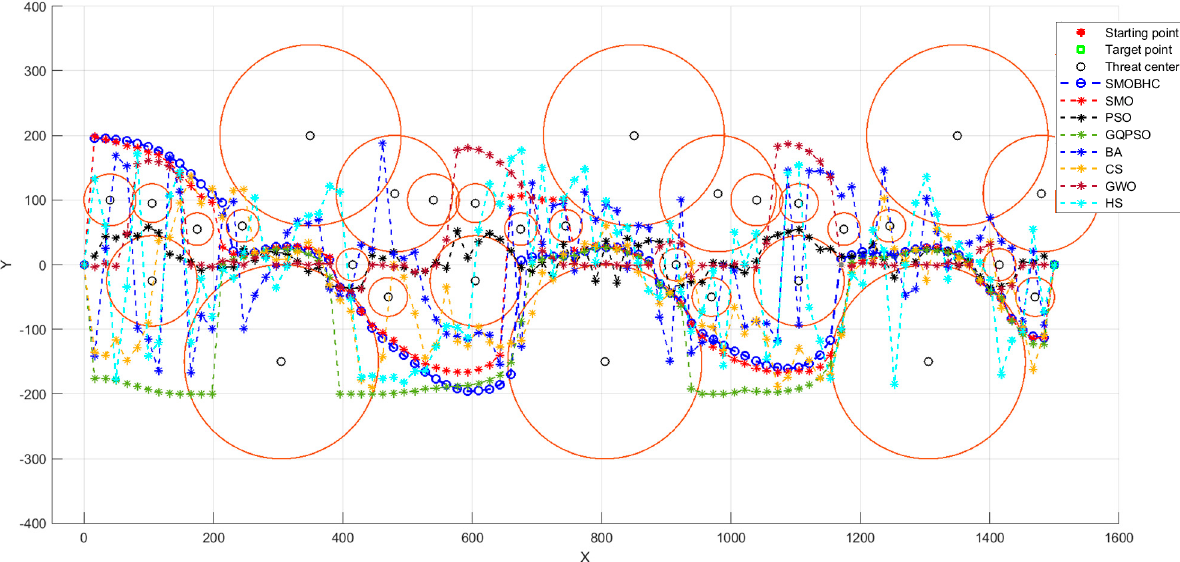
Figure 17. Comparison between SMOBHC and other seven algorithms for battlefield 2 with 𝐷 = 90 . Battlefield 3: